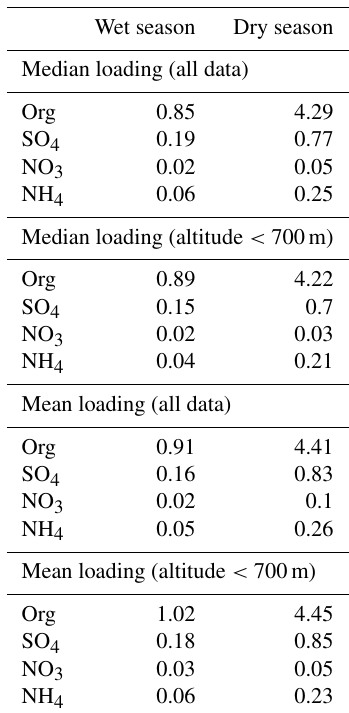
Table 2. Chemically resolved mass loading measured by the AMS on board the G-1. Mass loadings are normalized to 23 ◦ C and 1013hPa. Units are µgm − 3 . The statistics for altitudes below 700m approximate the boundary layer conditions at the time of the